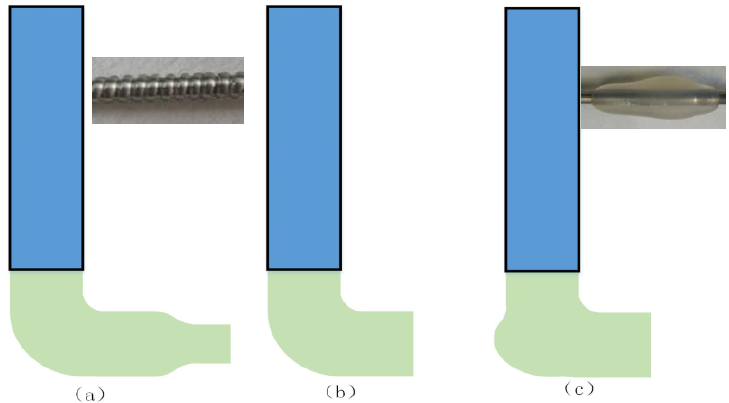
Figure 6. The initial shape of the extruded material. ( a ) W > U , ( b ) W ≈ U , ( c ) W < U.